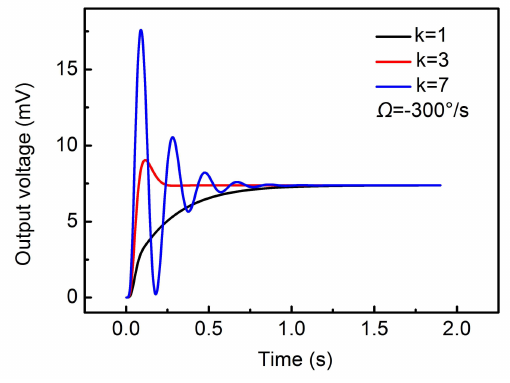
Figure 13. The stabilization time at different circuit gain